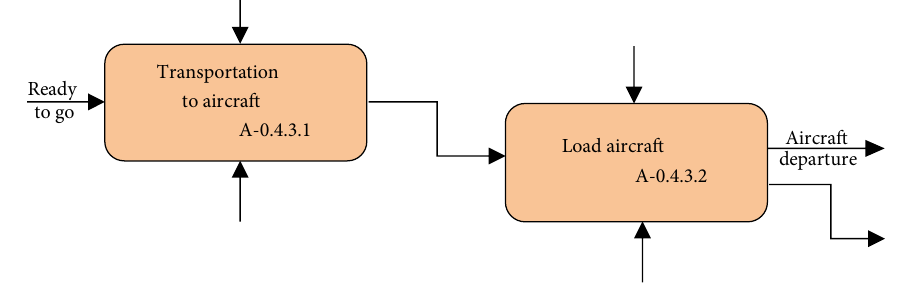
Figure 5: Further decomposition—air cargo handling subprocess